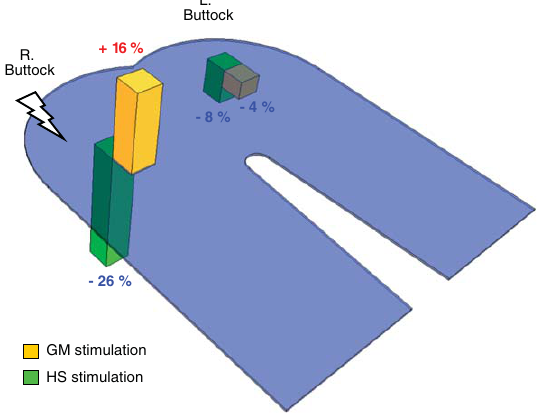
Fig. 6. Percentage pressure change in MPZs during surface stim- ulation ( n =10+1, see text): HS stimulation benefits both sides significantly more than GM stimulation, and especially so ipsilat- erally (where GM stimulation aggravates interface pressures).